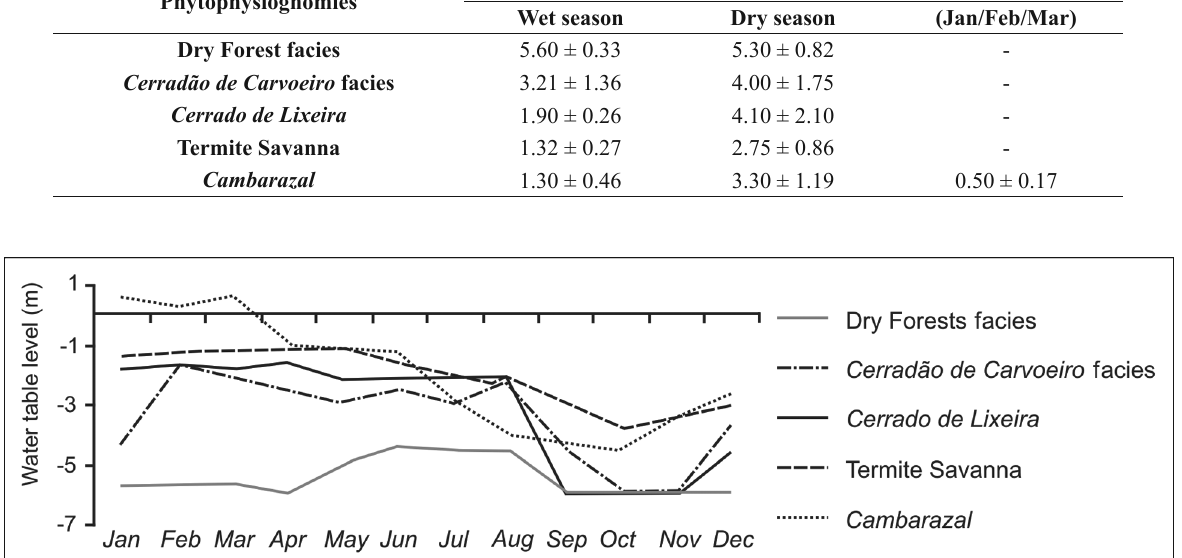
Water table average depth and average height of fl ood in all phytophysiognomies studied in RPPN SESC Pantanal, Brazilian Pantanal. Wet season = from December to May; Dry season = from June to November. Average values ± standard deviation. Water table average depth (m)